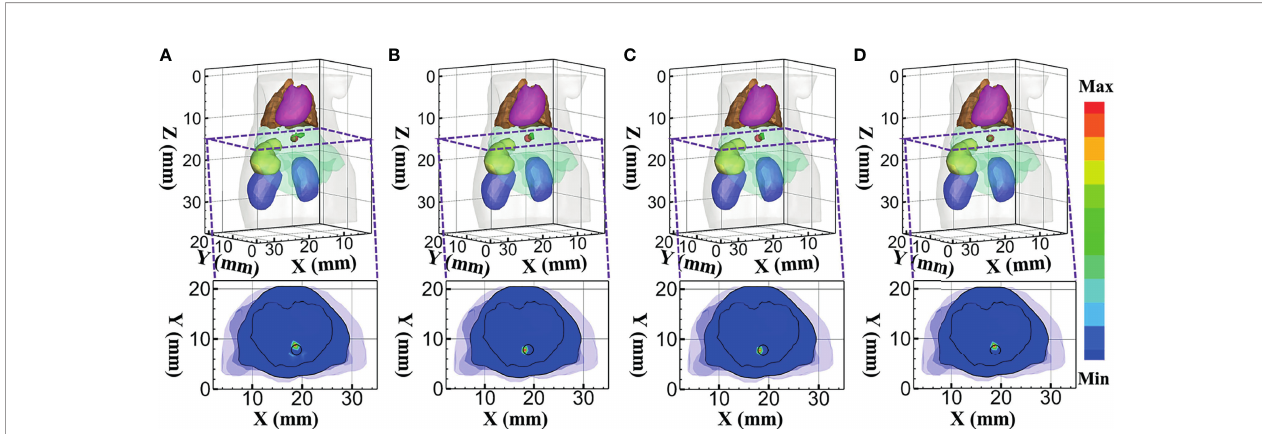
FIGURE 8 | Reconstructed results at 630 nm. (A – D) 3D views of the reconstructed results and the corresponding sectional images obtained by the DE-, SP 3 -, HDSM-, and MRHM-based methods, respectively.